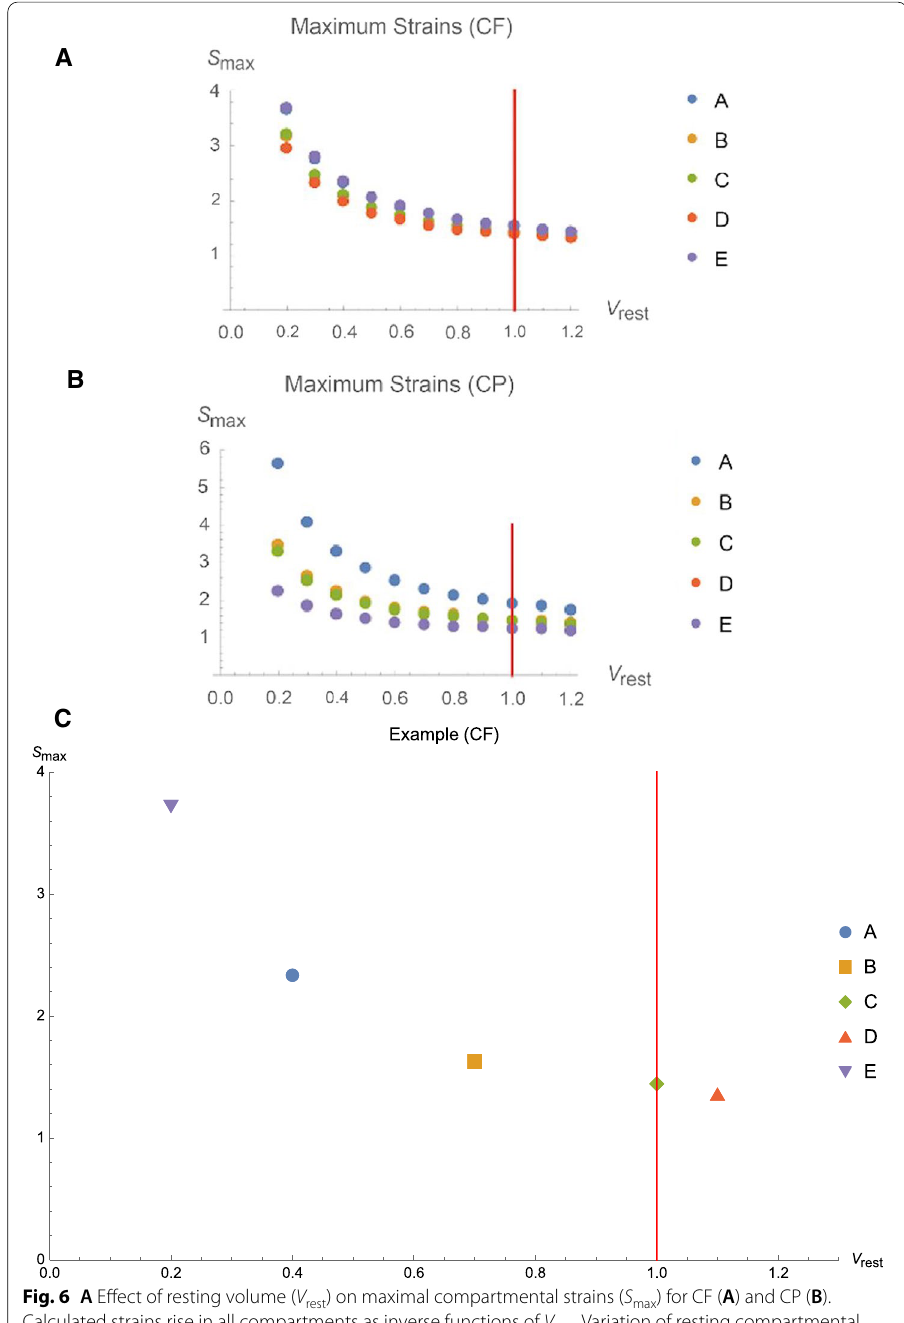
Fig. 6 A Effect of resting volume ( V rest ) on maximal compartmental strains ( S max ) for CF ( A ) and CP ( B ). Calculated strains rise in all compartments as inverse functions of V rest . Variation of resting compartmental volumes at maximal strain during constant flow ( C ). Note that each compartment has a unique resting volume at which strain is